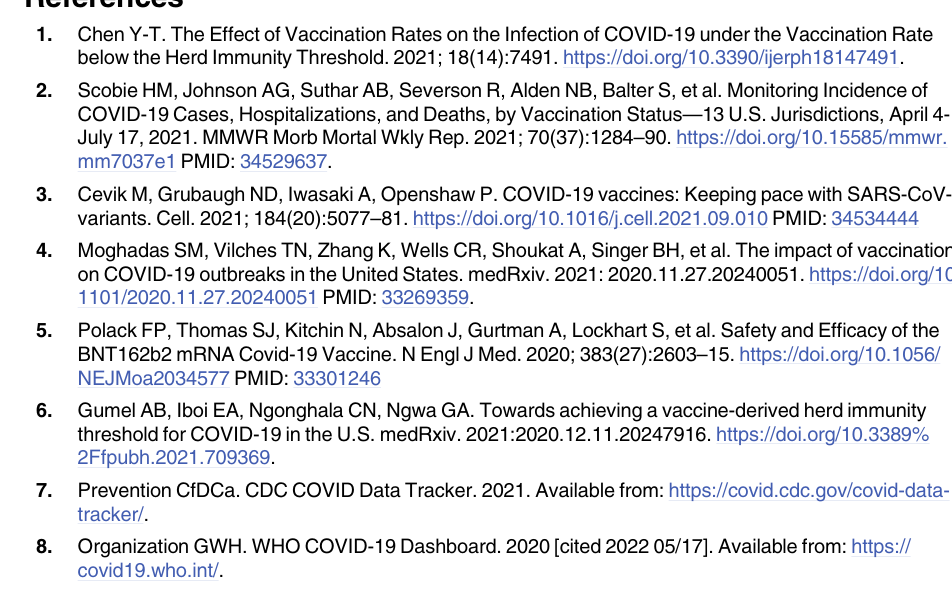
S2 Fig. Daily reported vaccination rate in the state of Florida, as reported by coronavirus. app (https://coronavirus.app). (TIFF) S3 Fig. Proportion of alpha (red), delta (blue), and all other variants in the United States over time, as reported by the Helix COVID-19 surveillance dashboard (https://www.helix. com/pages/helix-covid-19-surveillance-dashboard). (TIFF) S4 Fig. Cumulative confirmed cases in Florida. The median model prediction given esti- mates of social measures and vaccination rate as of Sept. 24 th , 2021 is given in black, while 1 yr, 2.5yr, and 5yr immunity waning periods are shown in red, green, and blue, respectively. The solid lines represent estimated vaccination rate, while the dashed lines represent a 1.5x increase in vaccination rate.